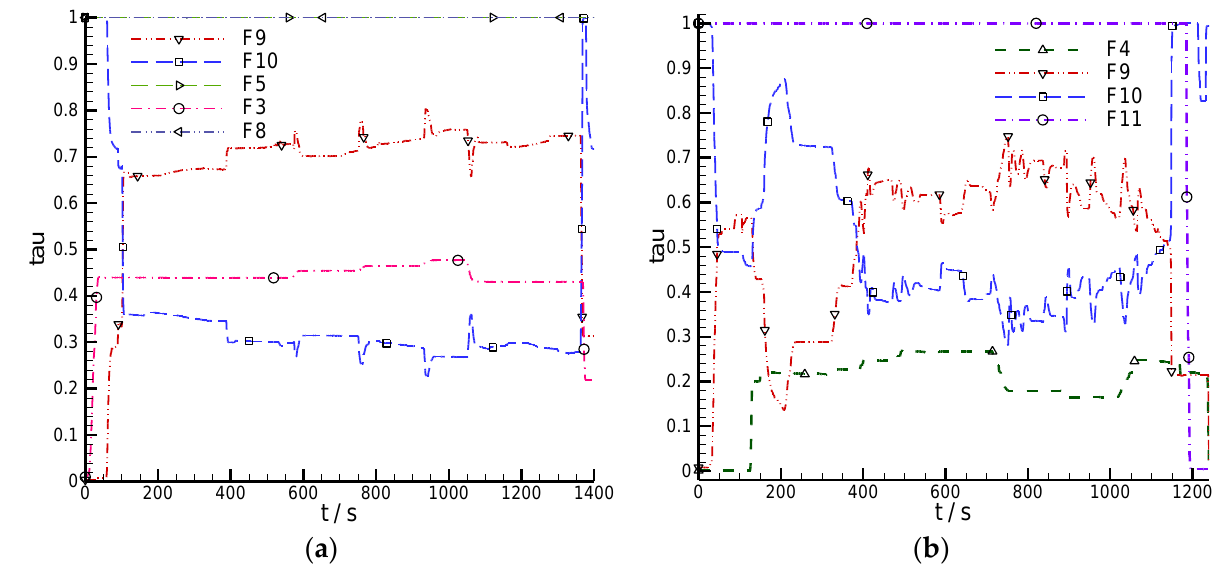
Figure 7. Regulating time sequence of two operating conditions of the core engine test rig main test system. ( a ) Normal- temperature condition; ( b ) low-temperature condition.